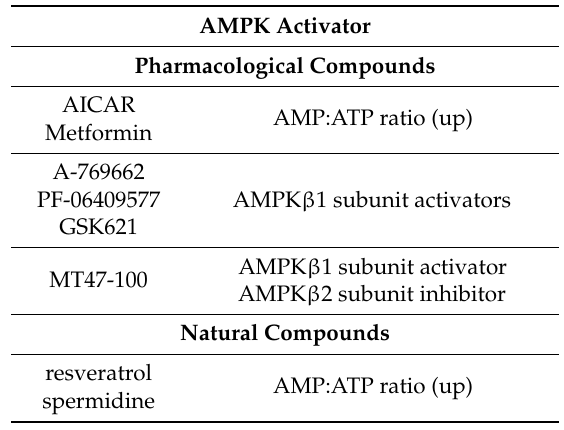
Table 1. AMPK activators include well-known pharmacological compounds, such as AICAR and metformin that act by increasing the AMP/ATP ratio, small molecules including A-769662, PF-06409577 and GSK621 that behave as AMPK β 1 subunit activator, and MT47-100, an AMPK β 1 activator and AMPK β 2 inhibitor. AMPK is also activated by a set of natural compounds including resveratrol and spermidine that indirectly increase the AMP/ATP